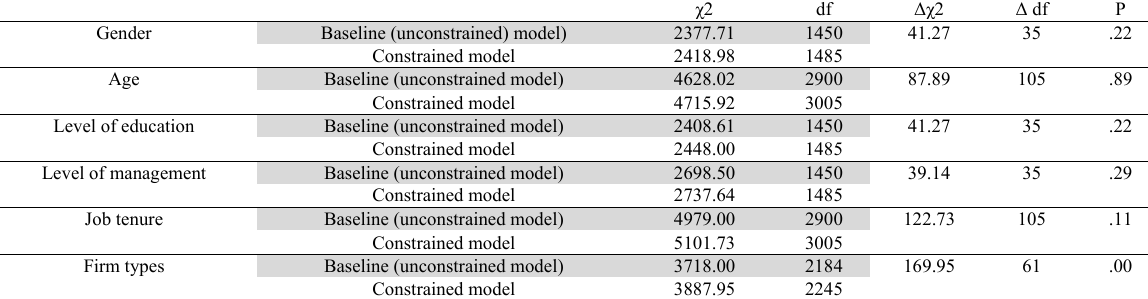
Results of the multigroup structural analysis